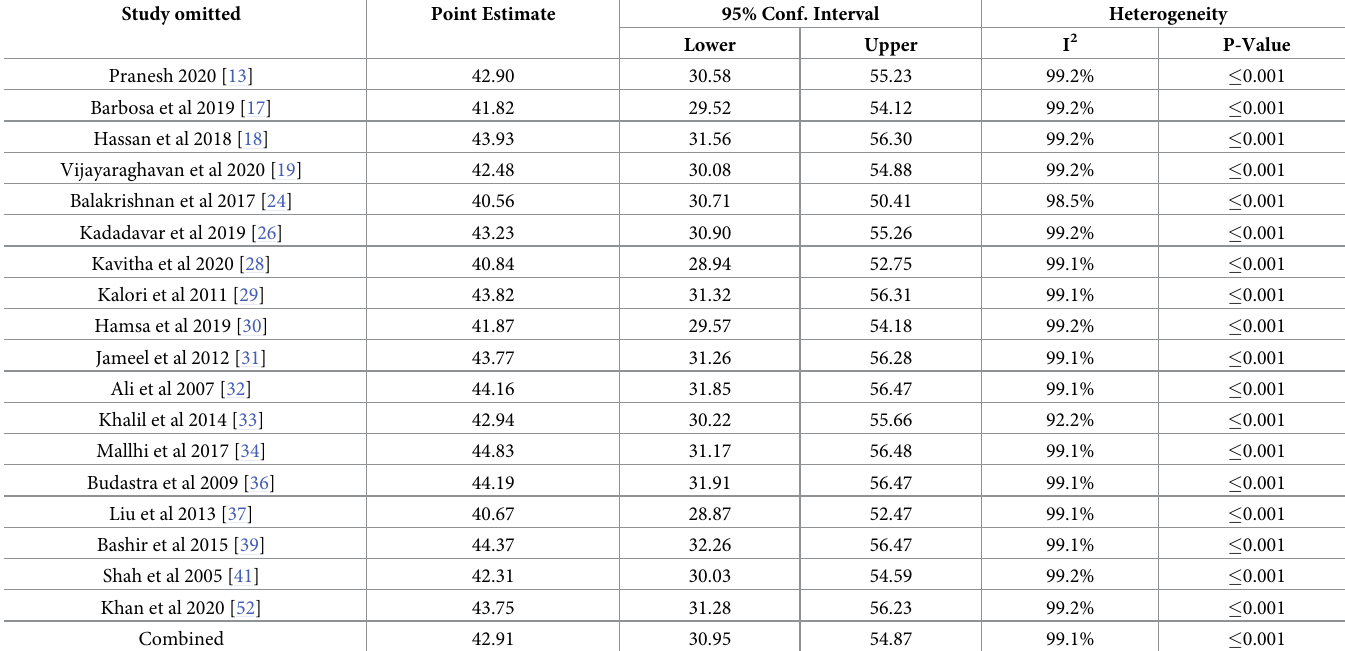
Table 2. Sensitivity analysis to estimate the effect each study on the magnitude of prolonged APTT among patients with dengue virus infection. Study omitted